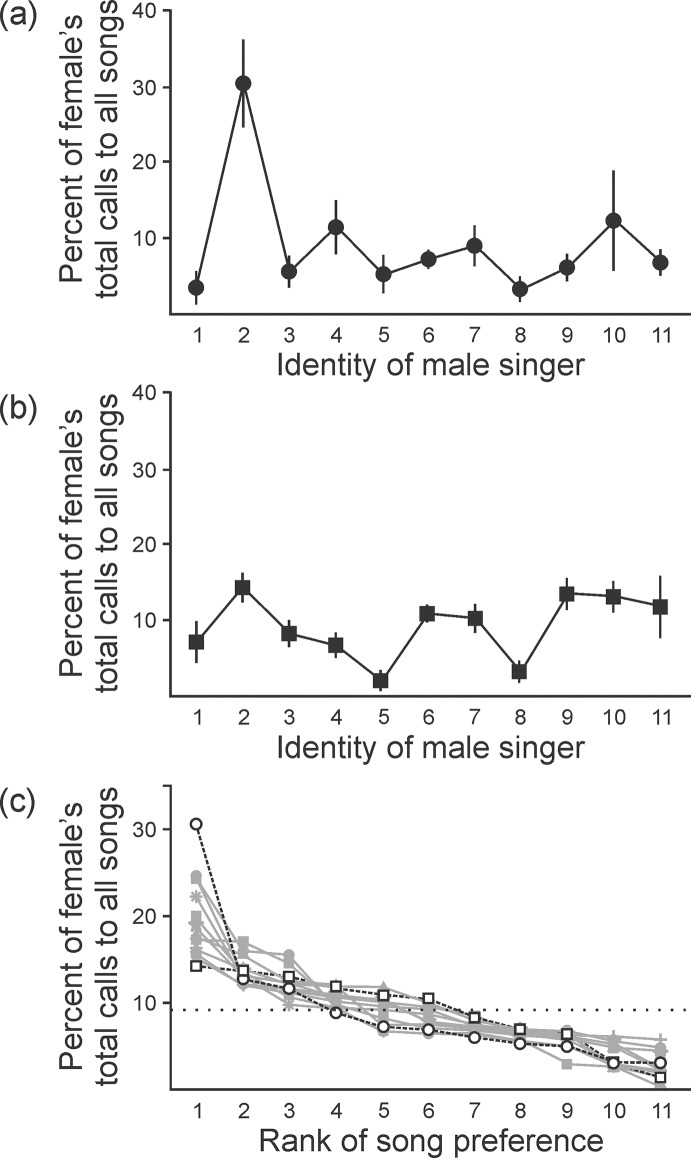
Females difference in their song preferences, but individuals were consistent in their preferences across time and tests.(a) Consistent with our previous study of female BFs mate choice (Dunning et al. 2014), some females were very selective in their preference for the song of an individual males (n = 1 bird; points indicate mean of 5 trials, lines indicate SE across the 5 trials). (b) Other females were not selective, responding similarly to the songs of many males (n = 1 bird, symbols as in panel (a)). (c) Across all birds that we tested, selectivity varied between the examples show in panels (a) and (b) (n = 12 birds; open circle indicates the bird in panel (a); open square indicates the bird shown in panel (b); different birds are indicated by different symbols; points indicate means of 5 trials, dotted line indicates level of chance).